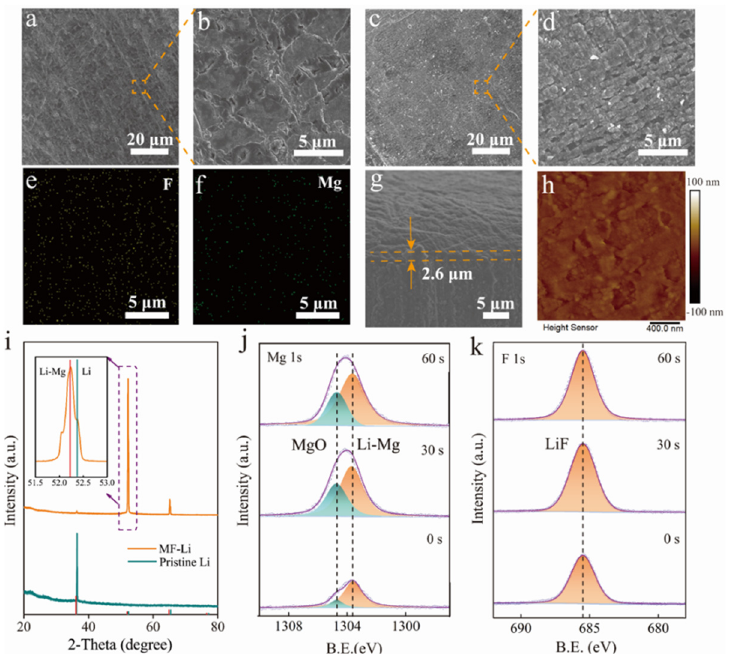
Figure 2. Characterization of the MF-Li anode. Top-view SEM images of the ( a,b ) pristine Li and ( c , d ) the MF-Li anode. EDS mapping images of ( e ) the F element and ( f ) the Mg element for the MF-Li anode. ( g ) The cross-sectional SEM image of the interphase. ( h ) AFM top view of the MF-Li anode. ( i ) X-ray diffraction pattern of the MF-Li and pristine Li anodes. High-resolution XPS depth profiles of ( j ) Mg 1s and ( k ) F 1s for the MF-Li anode.